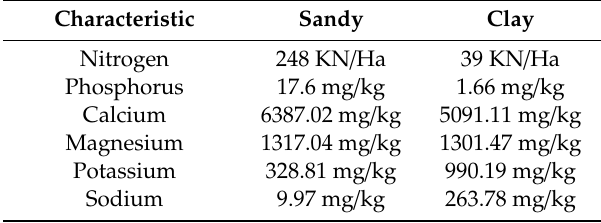
Table 2. Chemical characteristics of soils used in the study.